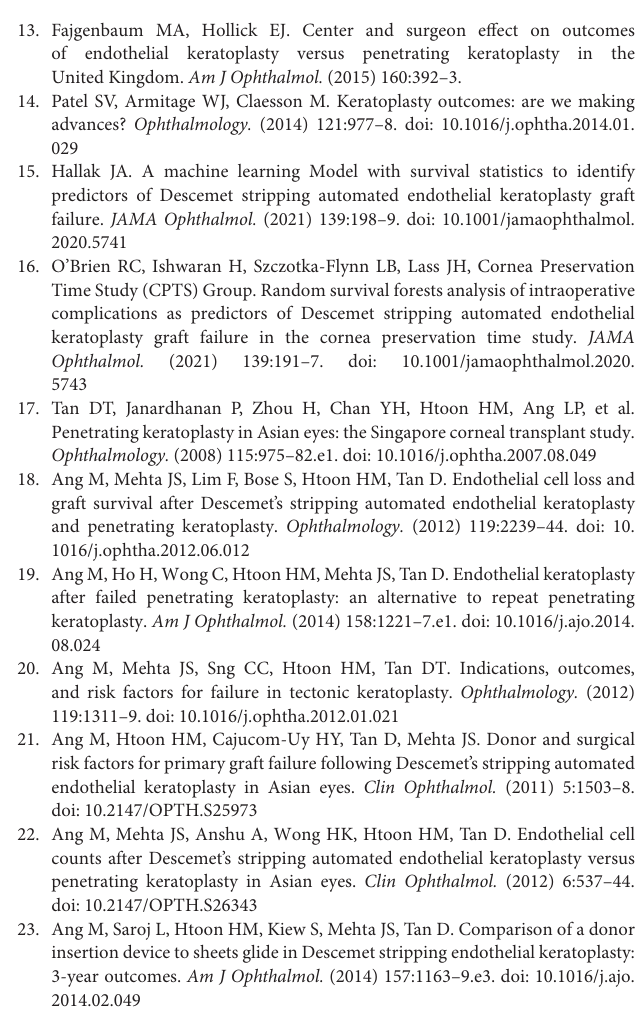
Supplementary Figure 1 | Boxplot showing the out of bag (OOB) Harrell C Statistic (C-index) of nested models using top variables identified by VIMP. Forward and backward step-wise multivariate Cox regression modeling only achieved OOB C-index of 0.576–0.686 (based on age, gender, race, diagnosis, surgery, glaucoma, donor age). Supplementary Figure 2 | Partial dependence plot showing the adjusted non-linear association between donor endothelial cell count and 10-year graft survival comparing Descemet stripping automated endothelial keratoplasty (DSAEK) and penetrating keratoplasty